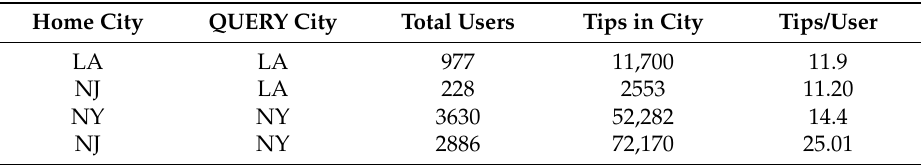
Table 1. Statistics of experimental data